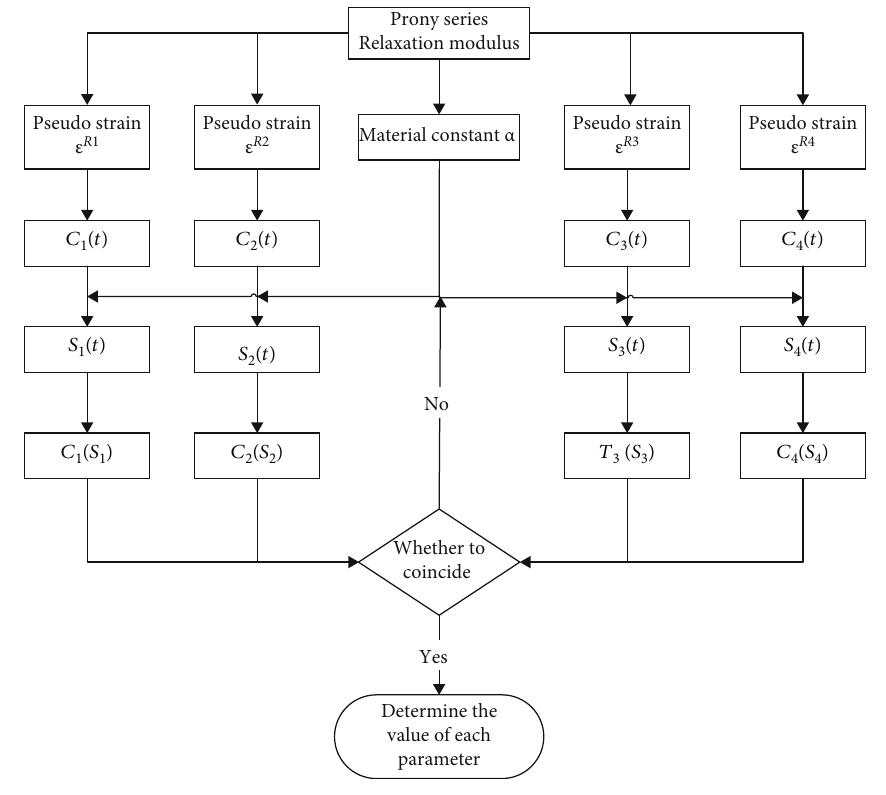
Figure 1: Flowchart of constitutive model parameter fi tting.